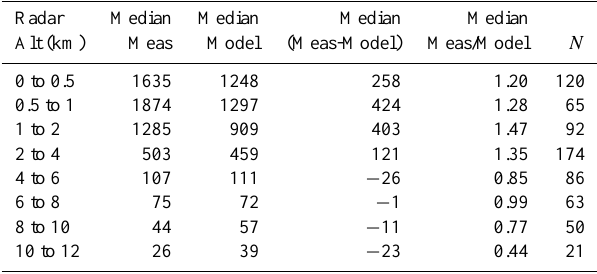
Table 1. Radar altitude bin statistics for time coincident TDLAS measurements (Meas) and box model (Model) results on the hy- drocarbon time base during the 1st phase of INTEX-B for the NASA DC-8. All measurement and model results, including (Meas- Model) are in pptv. The difference and ratios were determined from the point-to-point comparisons (i.e. comparisons where the ratios and differences were first determined for each point and the altitude- binned medians of these were then calculated).